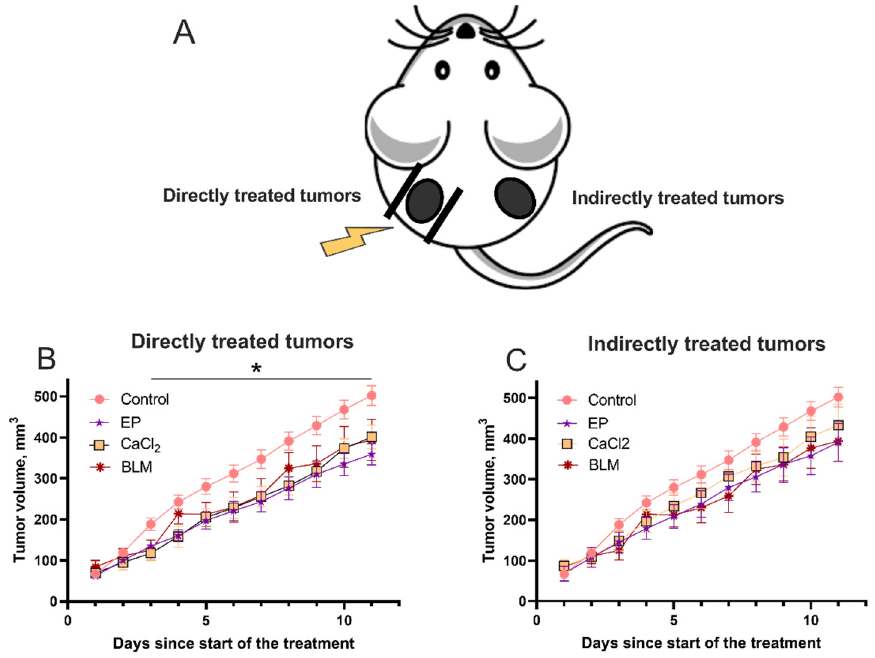
Figure 5. ( A ) An experimental setup of two tumors in one mouse to observe an abscopal effect. The electroporated or injected tumor is termed ‘directly treated tumor’, and the tumor that was directly untreated is termed ‘indirectly treated tumor’. Tumor growth changes in ( B ) treated tumor using electroporation or i.t. injection of CaCl 2 solution and ( C ) untreated tumor. Eight 1500 V/cm, 100 µ s duration pulses were used for the tumor electroporation. CaCl 2 solution (half of the tumor volume, 168 mM) was injected directly into the tumor. At least 8 mice with one tumor in each were indi- vidually treated for every experiment point. Statistically significant differences between individual experimental groups were evaluated using t -test. * symbol represents statistical significance ( p < 0.05) of comparison between EP and CaCl 2 treatments versus control (no treatment),